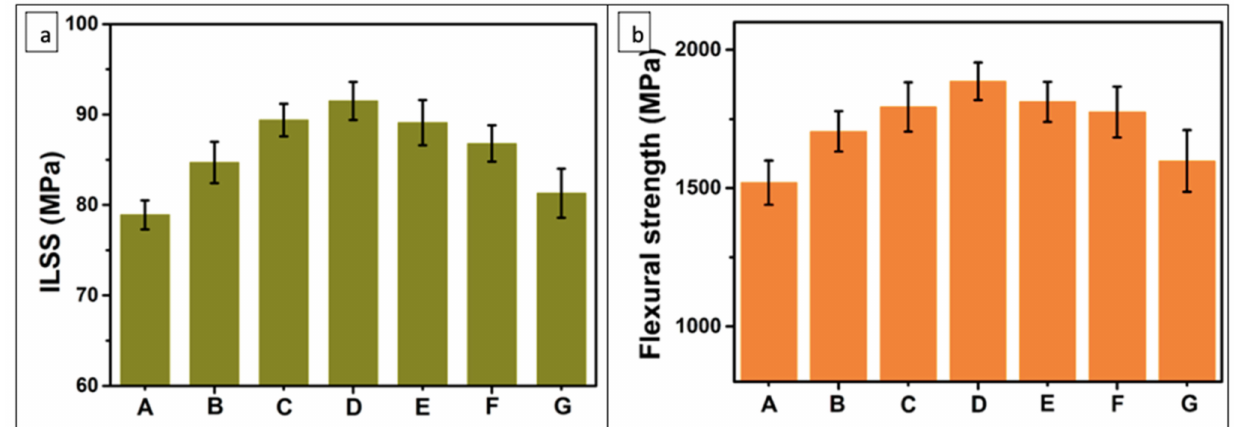
Figure 8. ( a ) Interlaminar shear strength; ( b ) flexural strength of composites: (A) untreated CF, (B) CF/GO (0.1%), (C) CF/GO (0.3%), (D) CF/GO (0.5%), (E) CF/GO (0.8%), (F) CF/GO (1.0%), (G) CF/GO (0.5% one step) GO wt.% content